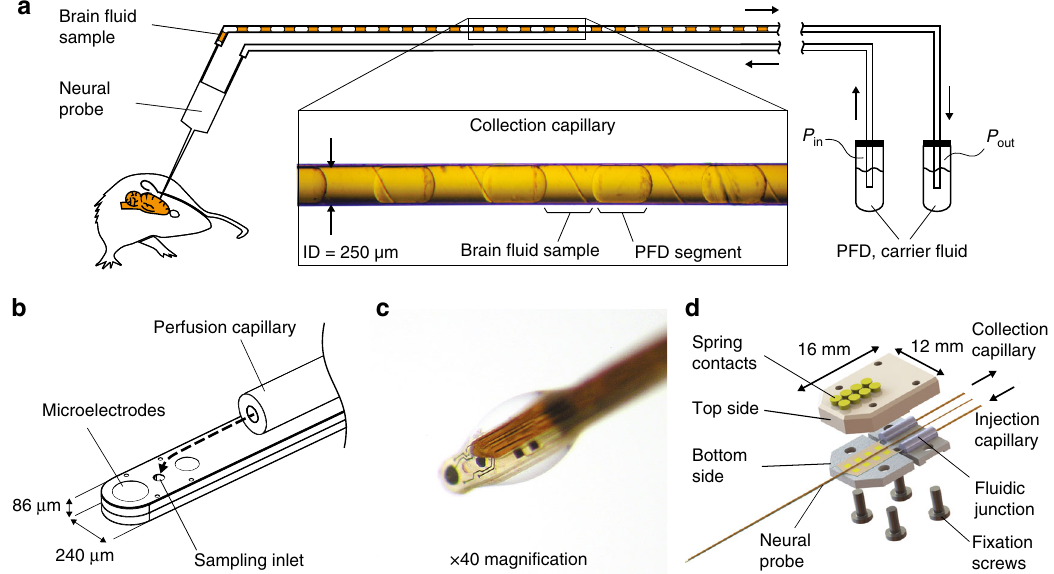
Fig. 1 Neural probe system including technical details regarding the perfusion and the interface unit. a The brain- fl uid samples are extracted using the neural probe and collected in a capillary. The samples are organized in a droplet train separated by Per fl uoromethyldecalin (PFD), a non-aqueous phase. The system is controlled by two pressure pumps applying the pressure P in and P out to two reservoirs fi lled with PFD. The regularly spaced diagonal patterns on the collection capillary are manufacturing defects of the tubing outer layer. b The perfusion capillary is situated in close proximity to the main elements included on the neural probe distal tip. The dashed line shows the shortest path of the injected perfusate before being recollected in the sampling inlet (push-pull function). c A drop of saline solution is released via the perfusion capillary demonstrating the functionality of the system. The droplet wets the surface of the probe including the sampling inlet. d 3D exploded view of the interface unit comprising the neural probe clamped between the bottom